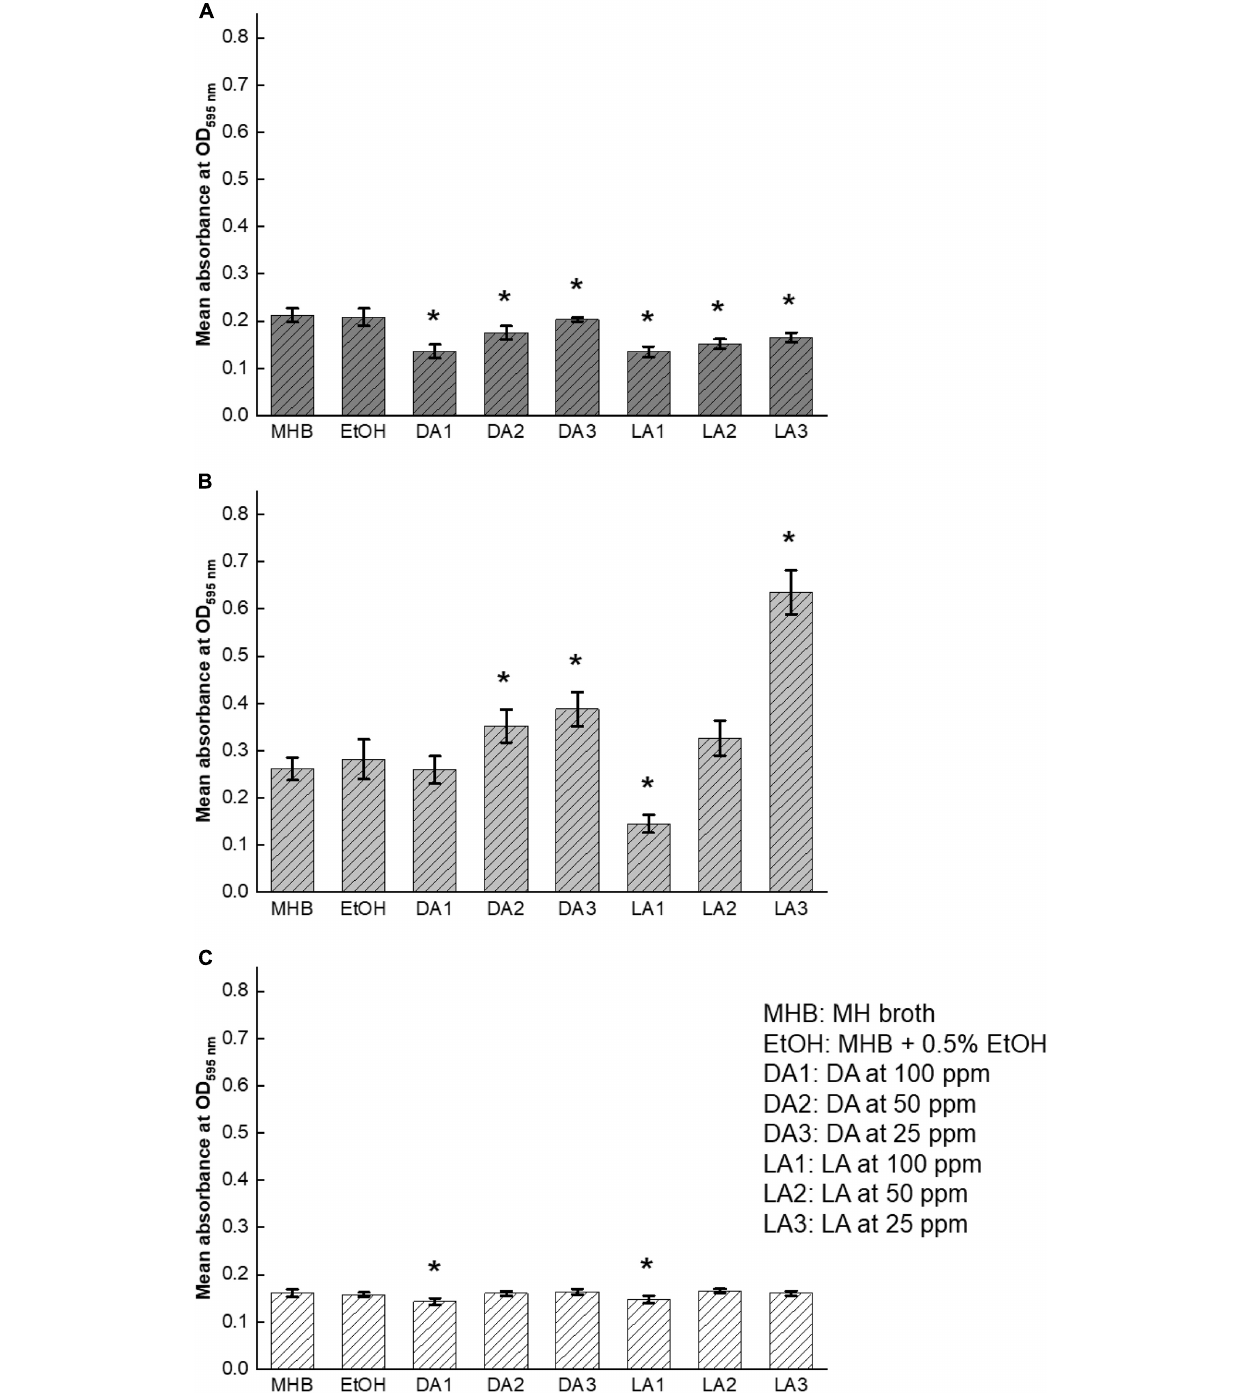
Frontiers in Microbiology |